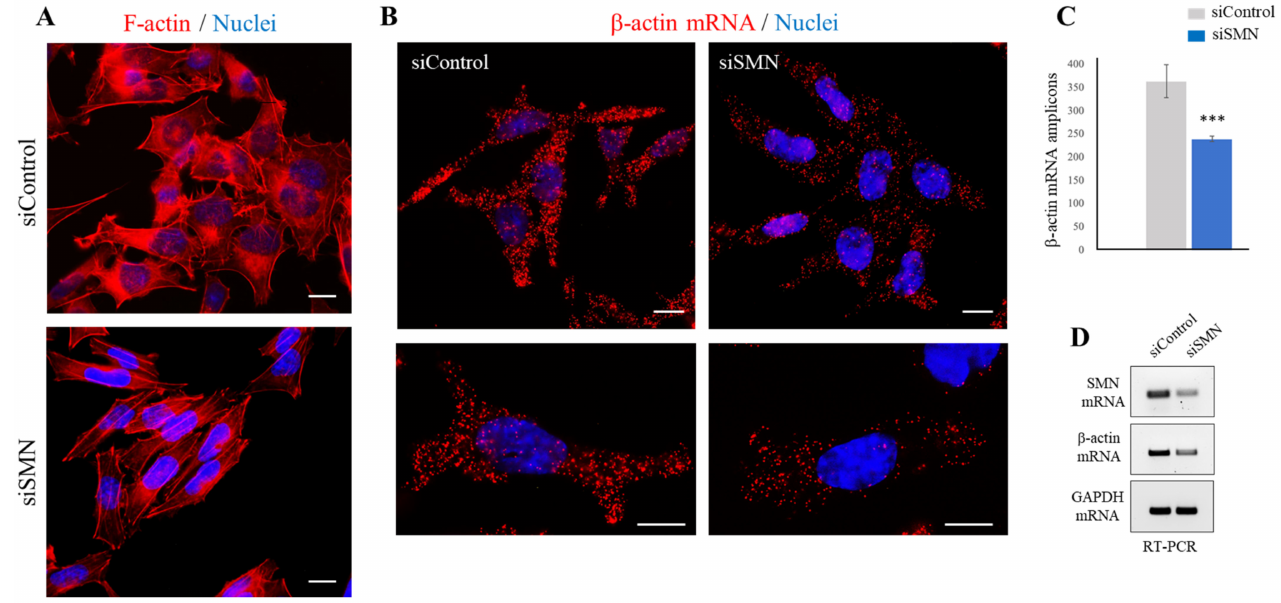
Figure 5. SMN knockdown dysregulates β -actin in HLaC-79 cells. ( A ) Representative images of fluorescence microscopy. siControl- and siSMN-transfected HLaC-79 cells were stained with Alexa Fluor 594-phalloidin to visualize the actin filaments (F-actin, red). Nuclei were labeled with DAPI. Scale bar 10 µ m. ( B ) Padlock assay targeting β -actin mRNA (red dots) in siControl-